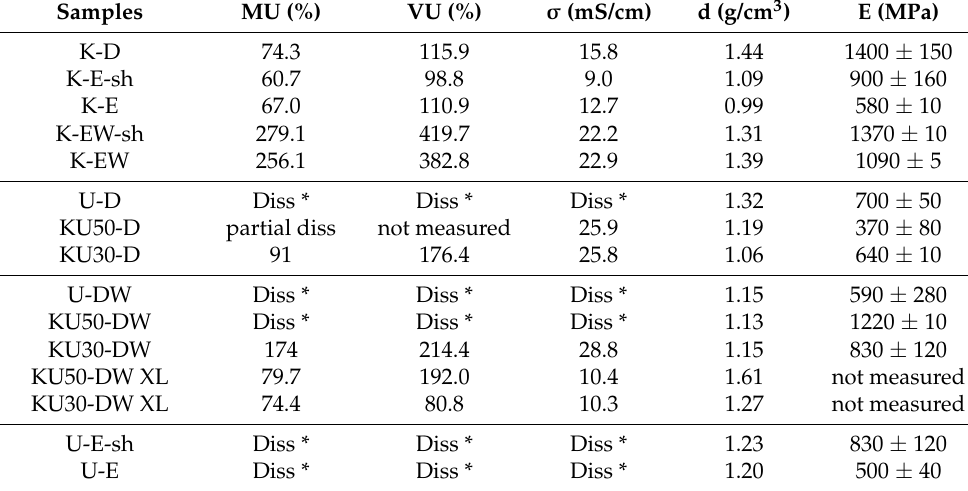
Table 2. Mass (MU) and volume (VU) uptake, conductivity ( σ ), dry density (d) and Young’s modulus (E) in humid air of various ionomer membranes. K stands for SPEEK, U for SPPSU, D for DMSO, W for water, and E for ethanol. XL (crosslink) indicates membranes thermally treated for 3 h at 180 ◦ C. sh specifies a short (15 min) heat treatment during